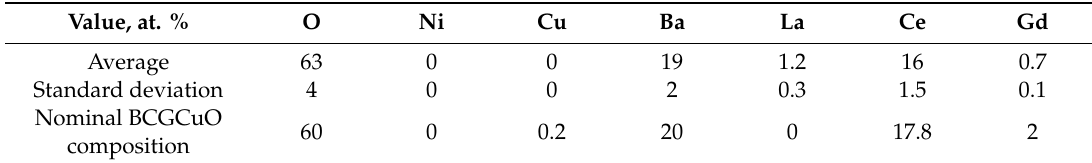
Table 2. The averaged elemental composition of the BCGCuO film on the modified cathode LBNO after final sintering at 1450 ◦